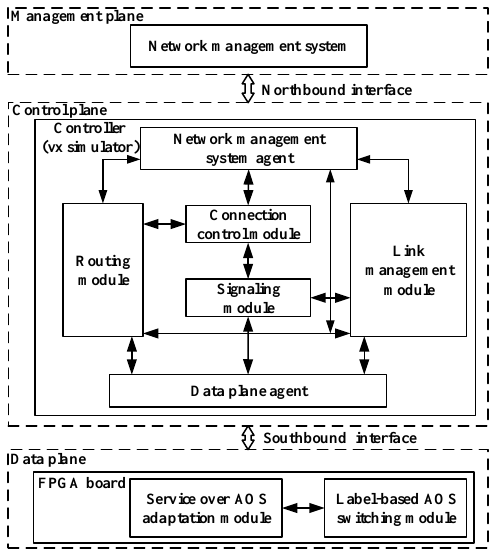
Figure 4. The framework of SDN-based ISTNs simulation